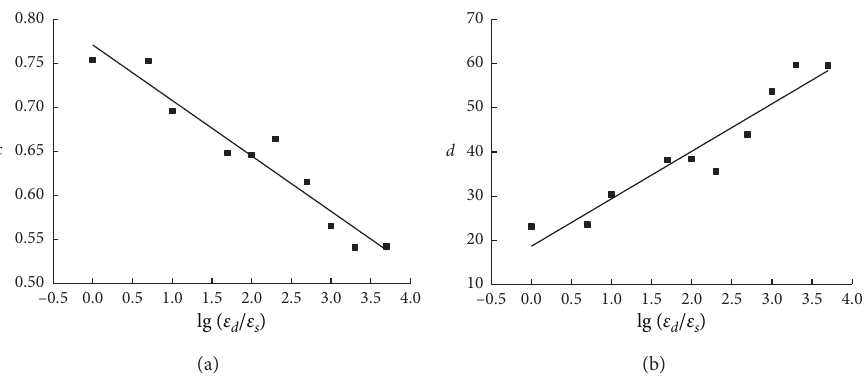
Figure 13: Relationship between size effect law parameters and loading strain